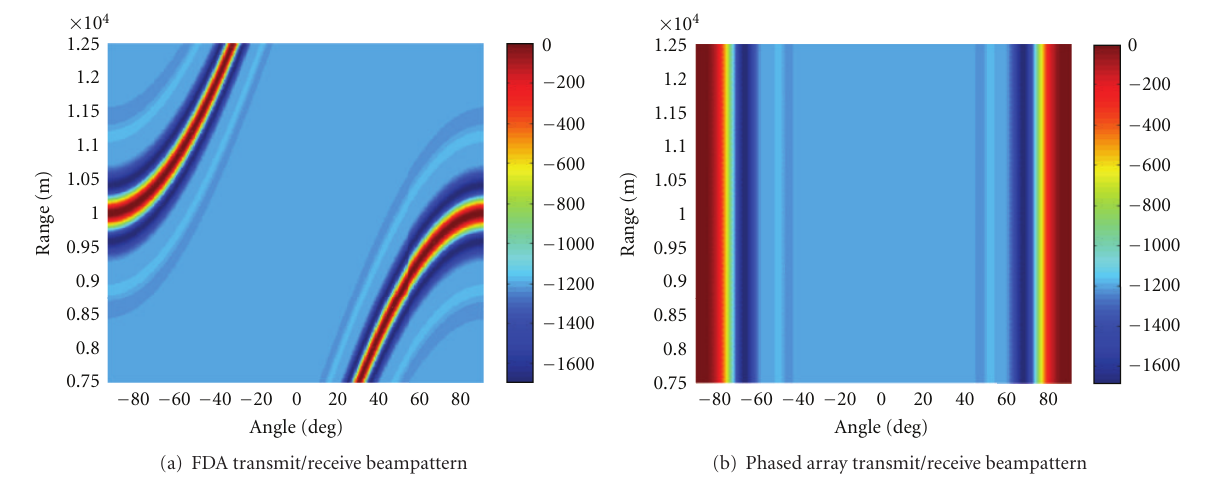
Figure 6: The overall transmit/receive beampattern when compared to a phased array.